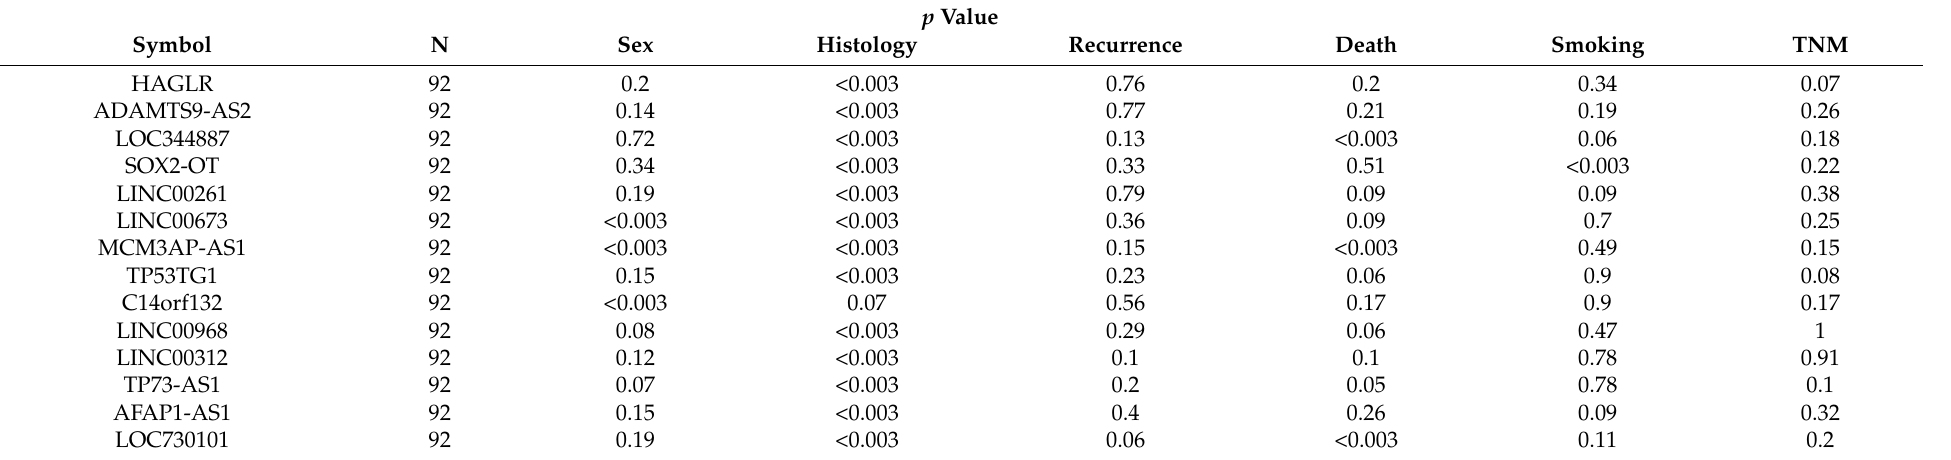
Table 5. Expression of lncRNAs and clinicopathological parameters of NSCLC